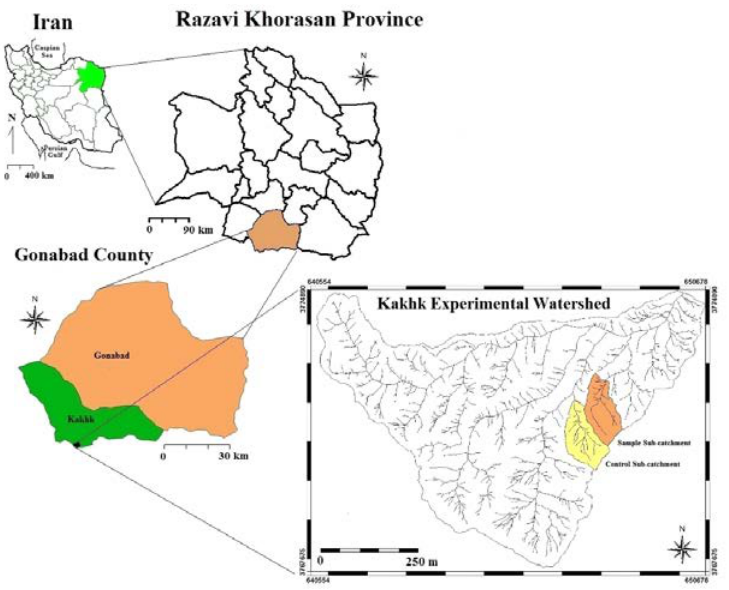
Fig. 1: Location of the study area Table 1: Physical characteristics of the control and sample